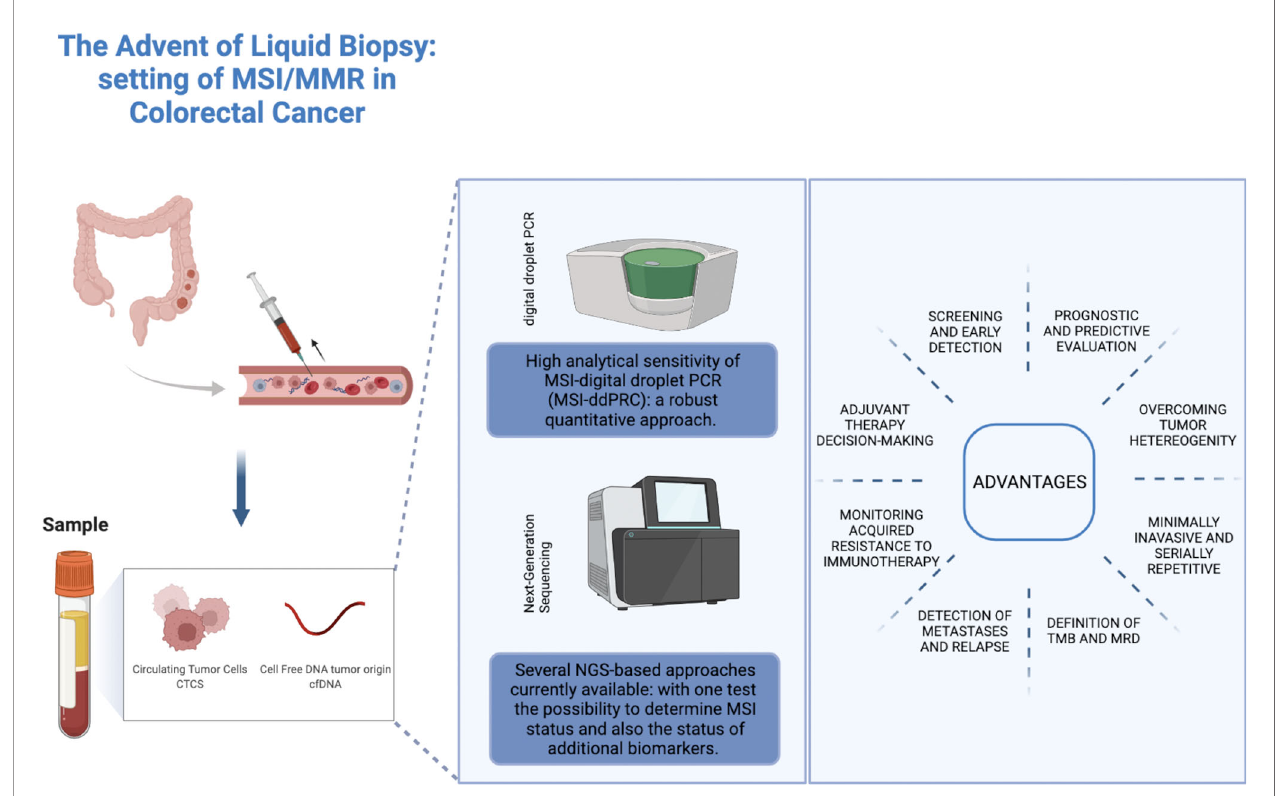
FIGURE 1 | Role of liquid biopsy approaches in the determination of MSI status in colorectal cancer. Credit by